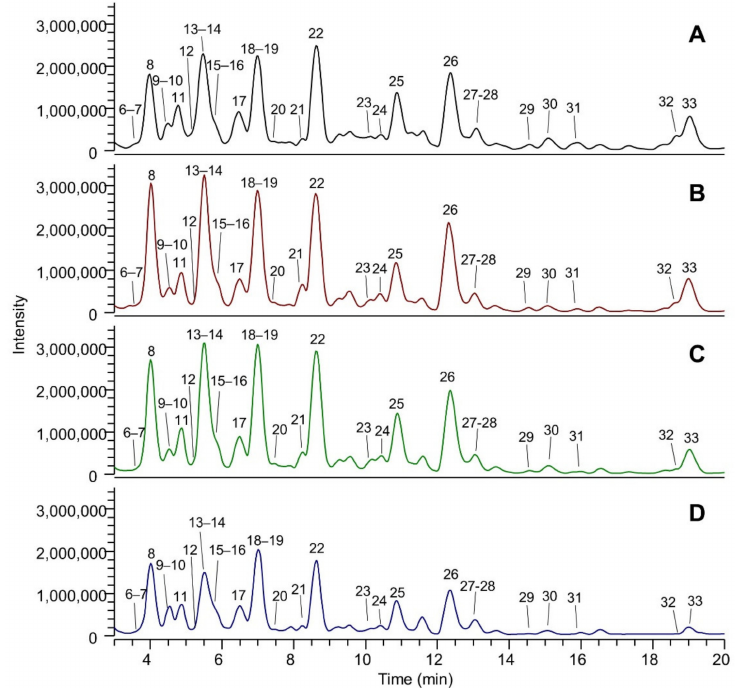
Figure 2. Magnification (range time 3–20 min) of the LC-ESI-(-)-MS total ion currents (TICs) recorded in negative ion mode of the four extracts: ( A ) EtOH-H 2 O 70:30 (% v / v ); extract A; ( B ) water at 100 ◦ C, extract B; ( C ) water at 70 ◦ C extract C; ( D ) water at room temperature, extract D. Identified peaks (group A) are numbered progressively based on the RT and their assignment is reported in Table